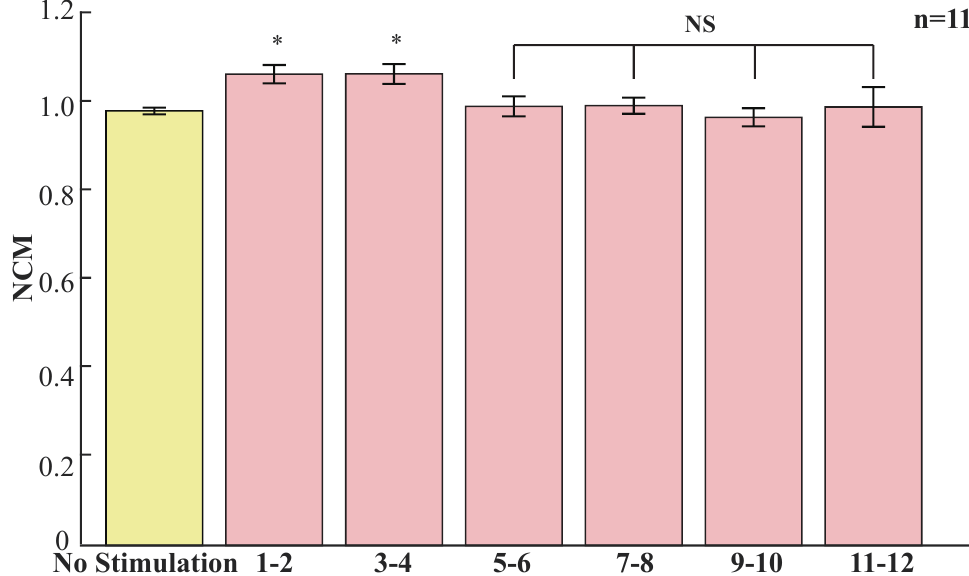
Figure 4. Continuous light stimulation reduced the 20–30 Hz response. No stimulation (yellow) com- pared to 1–2, 3–4, 5–6, 7–8, 9–10 and 11–12 cycles during light exposure (red), on average, 20–30 Hz NCM ( ± SEM); n = 11 flies; the first twelve cycles were recorded. Significance was determined by two-tailed t -test; *, p < 0.05; NS, p >